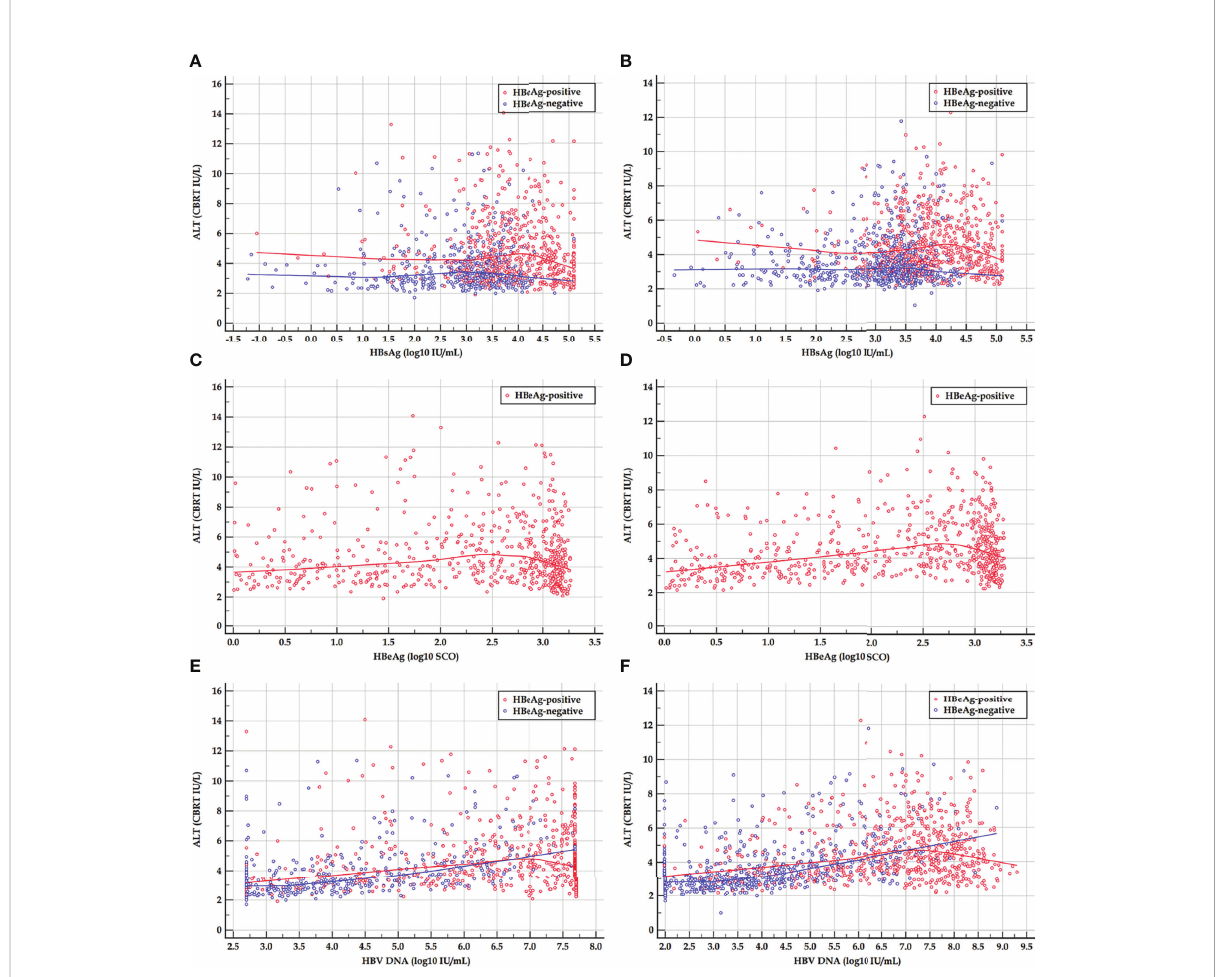
FIGURE 1 Scatter plots and LOESS regression curves between ALT and HBsAg, HBeAg, and HBV DNA in HBeAg-positive and HBeAg-negative cohorts. (A, C, E) Early HBeAg-positive and HBeAg-negative cohorts. (B, D, F) Late HBeAg-positive and HBeAg-negative cohorts. LOESS, locally estimated scatter plot smoothing; ALT, alanine transferase; HBsAg, hepatitis B surface antigen; HBeAg, hepatitis B e antigen; HBV DNA, hepatitis B virus DNA; CBRT, cubic root; log 10 , logarithm with base 10. The red and blue curves are LOESS regression trend lines in HBeAg-positive and HBeAg-negative cohorts. The degree of smoothing is controlled by a span of